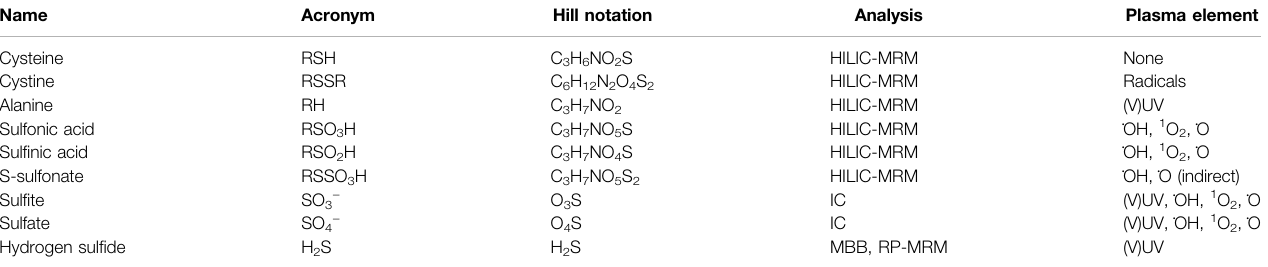
TABLE 2 | Analyzed cysteine derivatives, acronyms, formulas, quanti fi cation method and responsible plasma element.